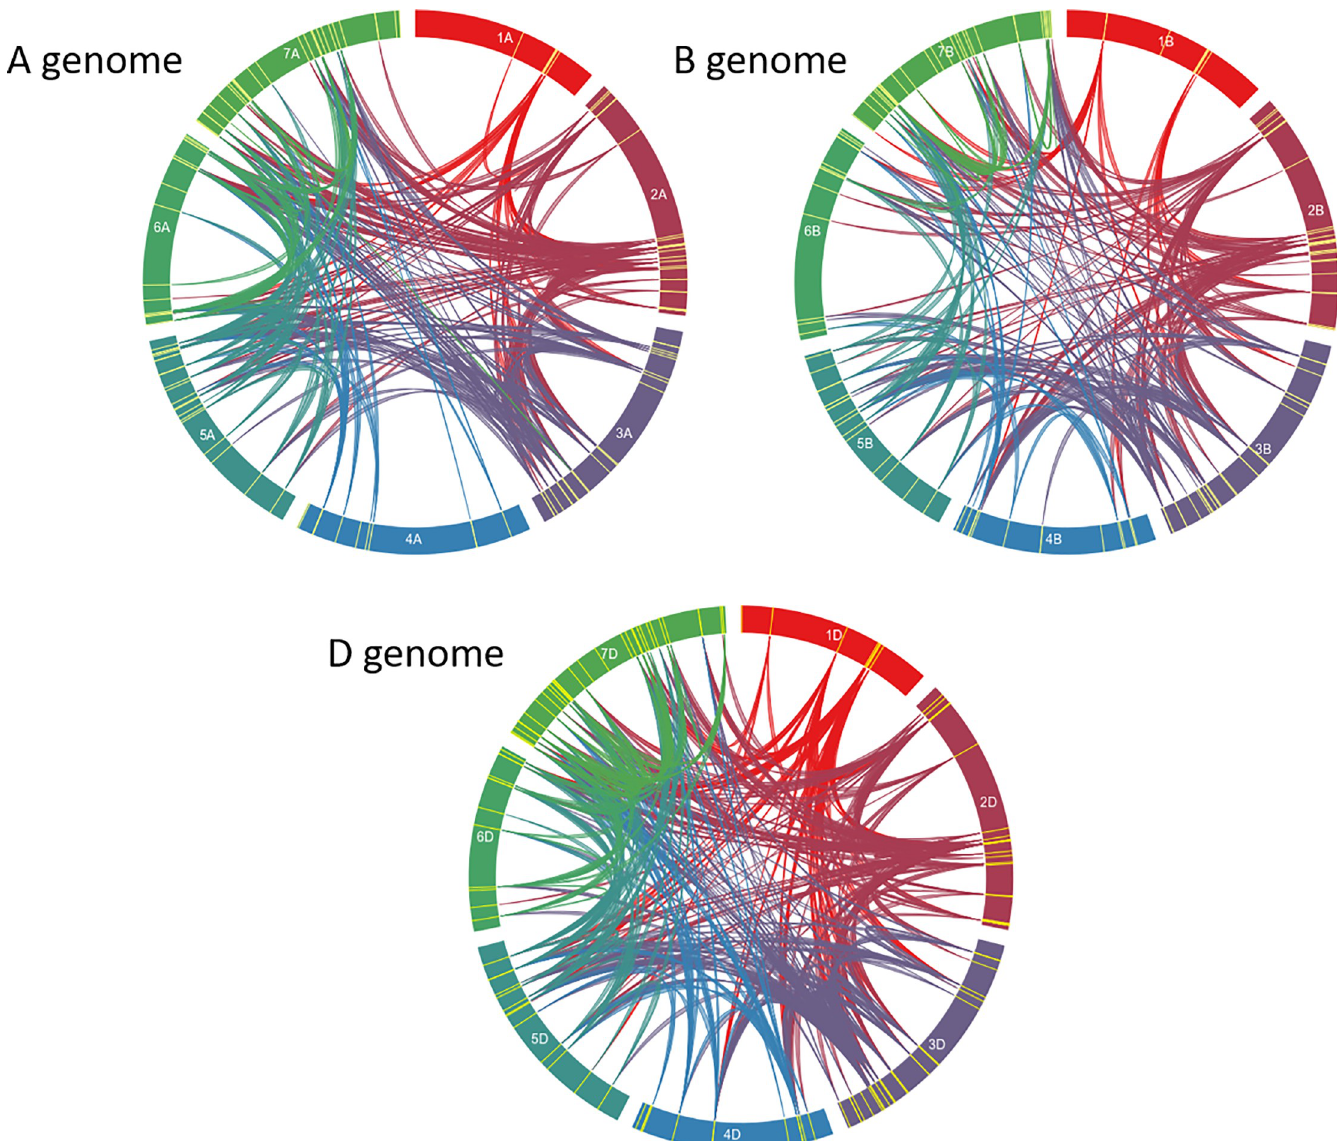
Fig 2. Circos diagram of the seven chromosomes of genomes A, B, and D. Yellow features indicate the presence of a TaNAC. Bands link two chromosomal regions with more than 90% of homology and a minimal length of 3 Kb.